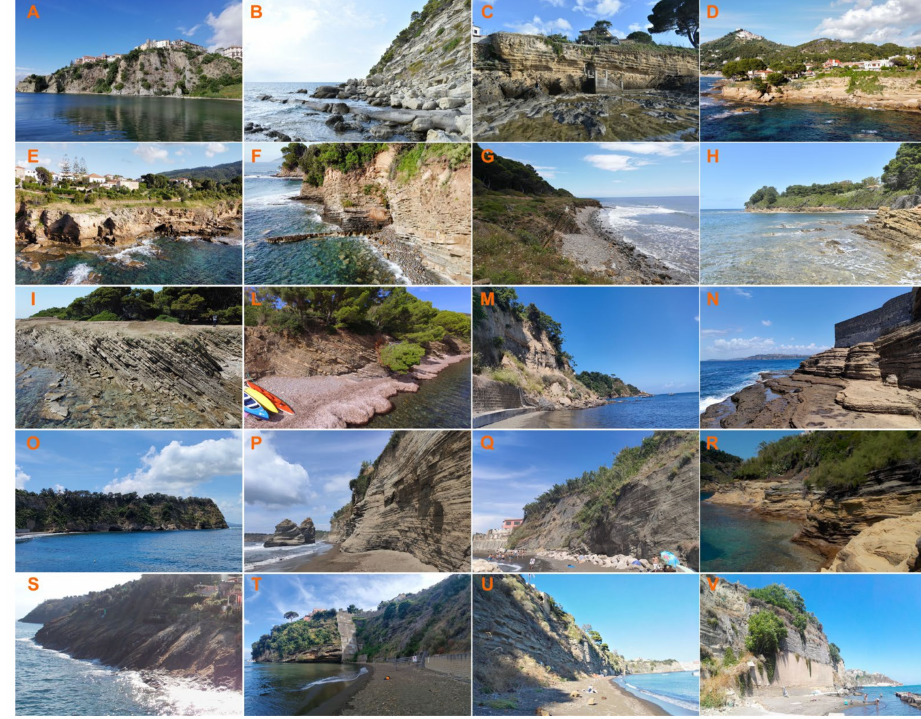
Figure 3. Studied cliffs along the Cilento area ( A – L ) and Procida Island ( M – V